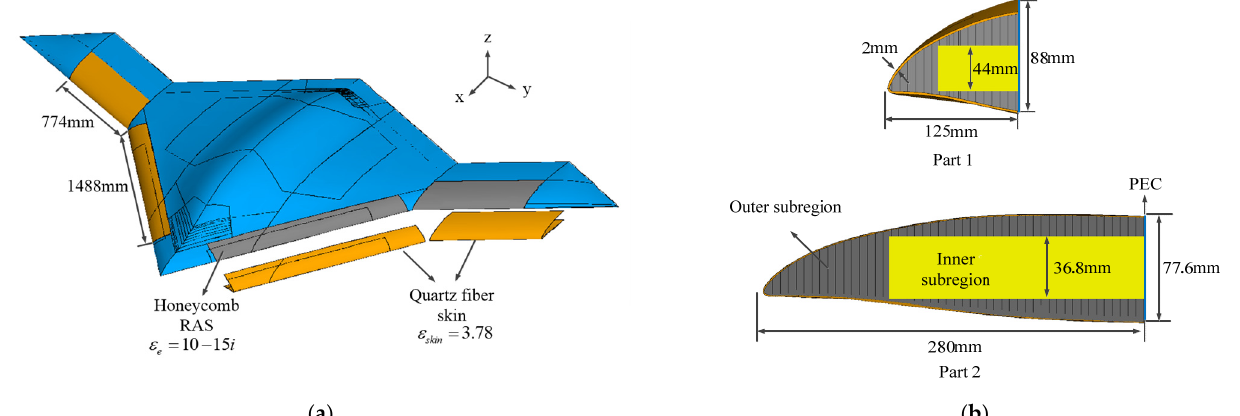
Figure 13. Geometry of a UVA model with radar-absorbing honeycomb structures: ( a ) overview of the UVA object; ( b ) side view of the wing with honeycomb structure.